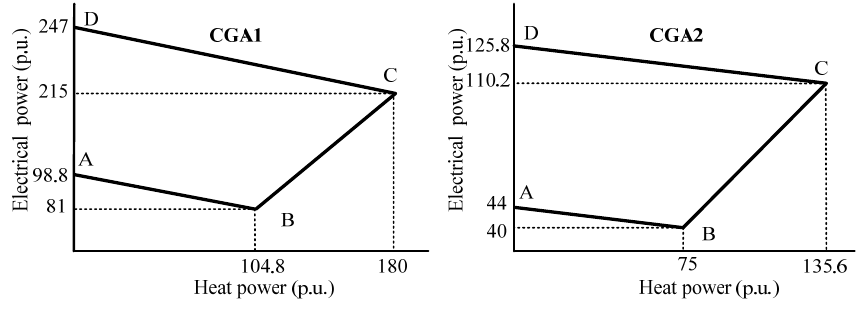
Figure 3. The 16 ‐ bus test system.